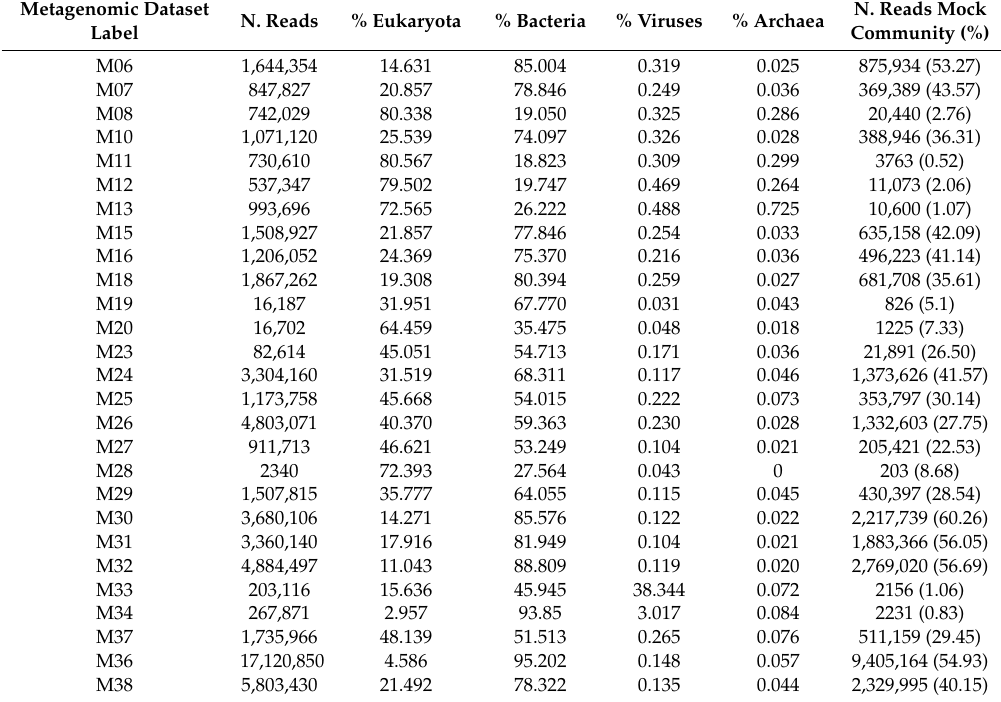
Table 3. Number of reads in each metagenomic dataset obtained from spiked salmon. For each dataset, the percentage of reads assigned to Eukaryota, Bacteria, Viruses, Archaea, the number of reads belonging to the microorganisms of the mock community, and their percentage in relation to the total number of reads are detailed.